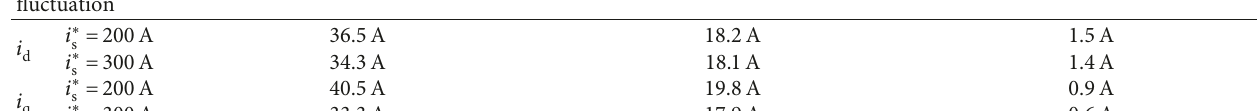
Peak-to-peak of the